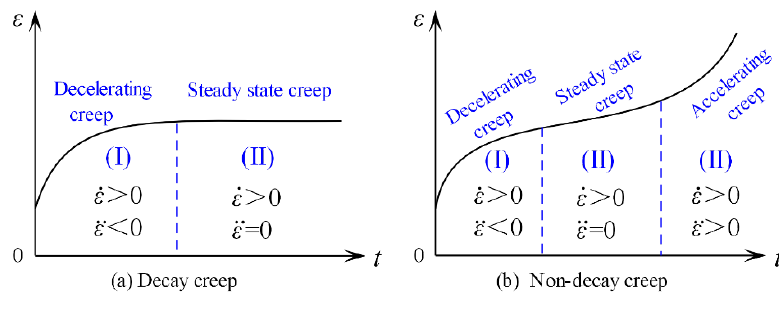
Figure 6. Creep characteristic of coal specimens.